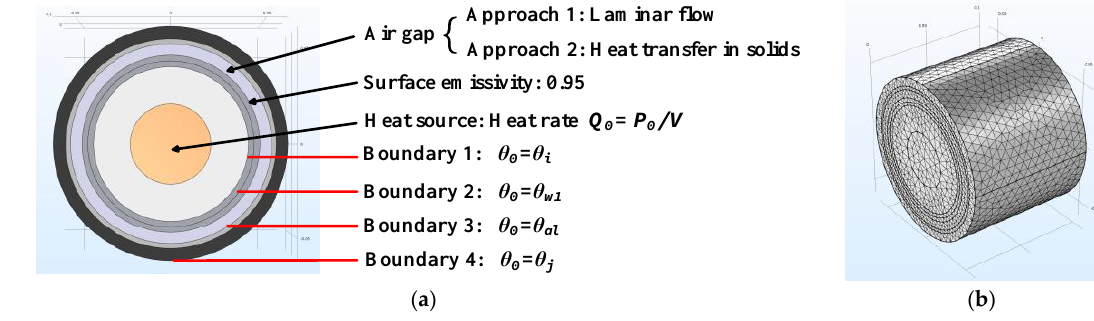
Figure 5. Finite element method (FEM) simulation model: ( a ) conditions and ( b ) mesh generation.